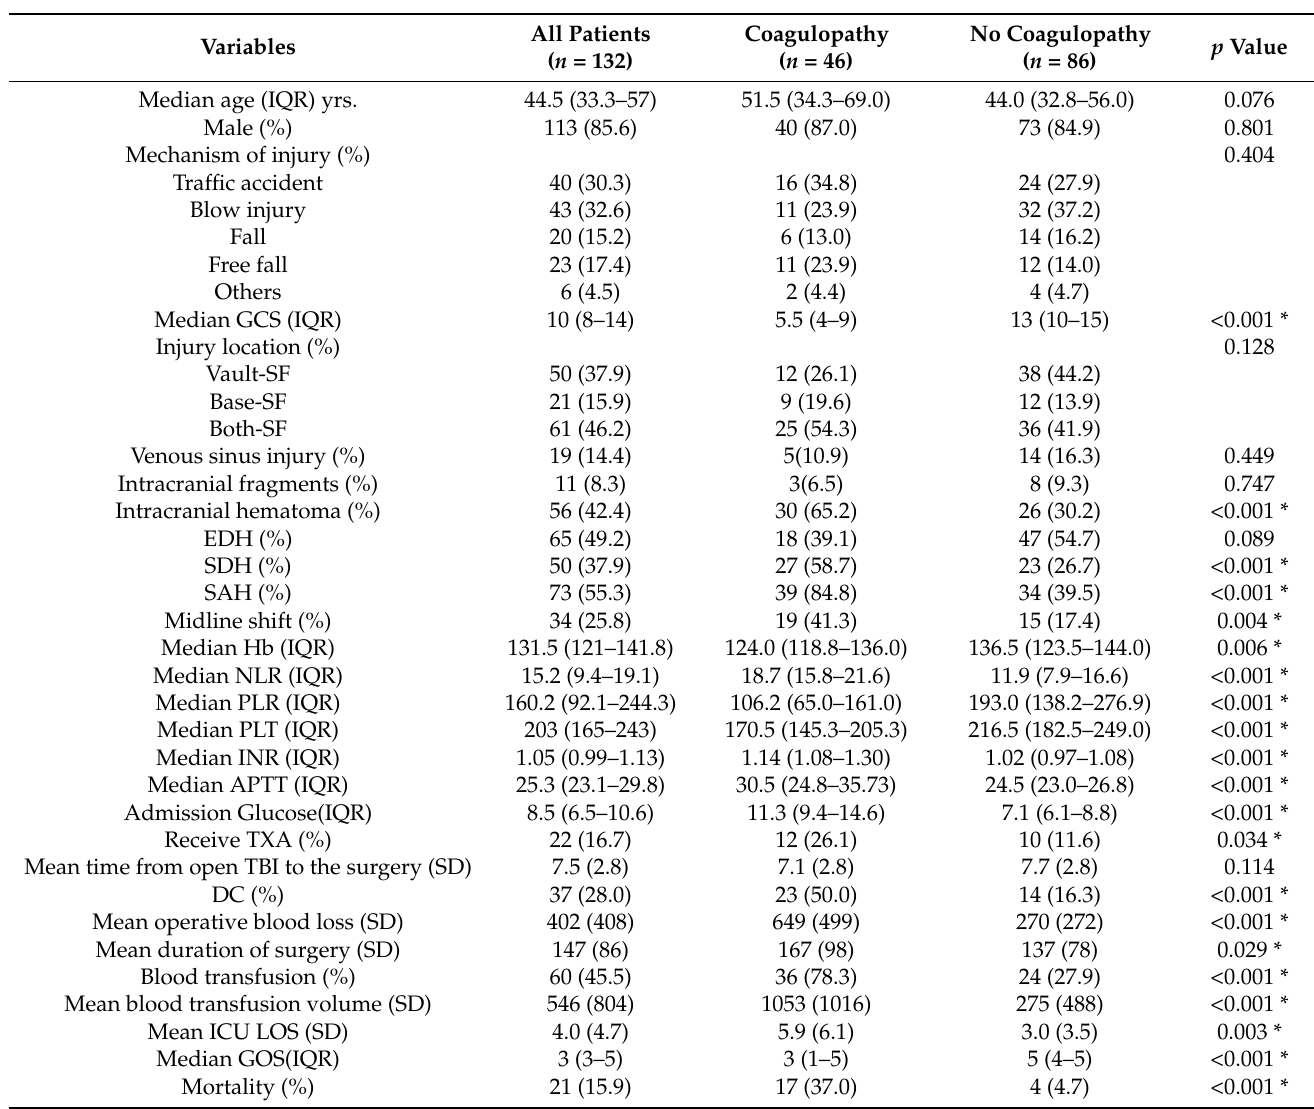
Table 1. Comparison of baseline demographics and clinical characteristics of patients with and without coagulopathy after open